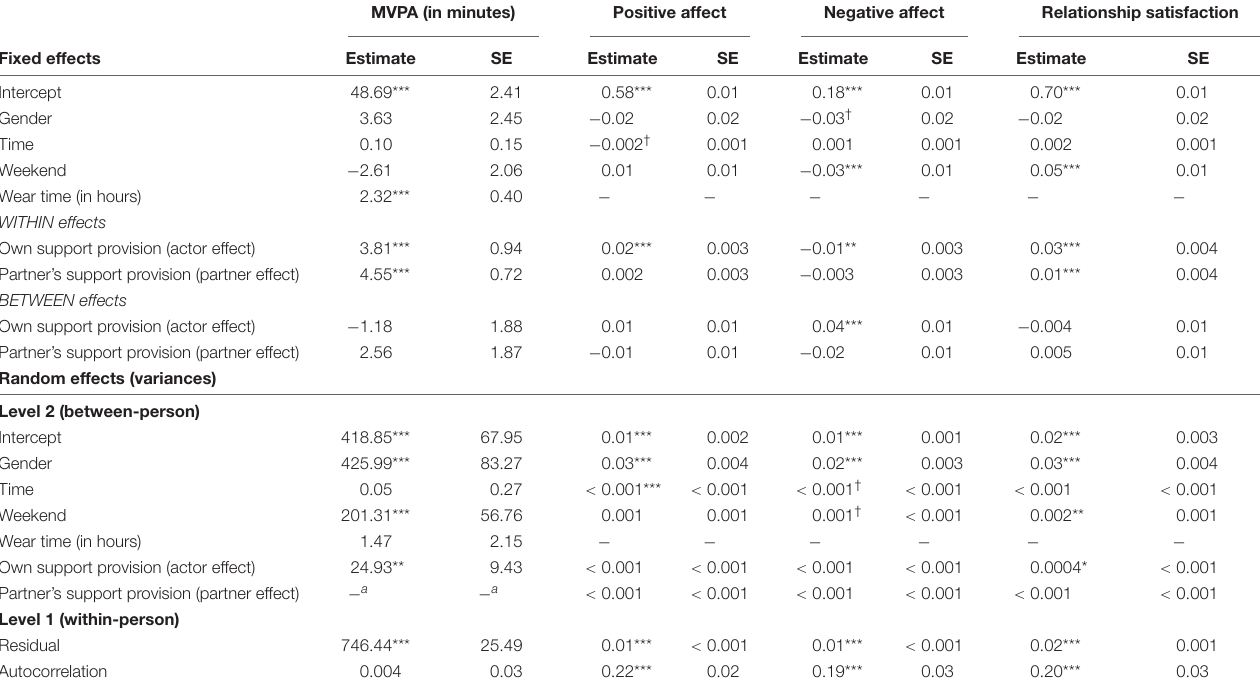
TABLE 2 | Parameter estimates from mixed models testing the effect of support provision on couples’ daily MVPA, positive and negative affect, and relationship satisfaction. MVPA (in